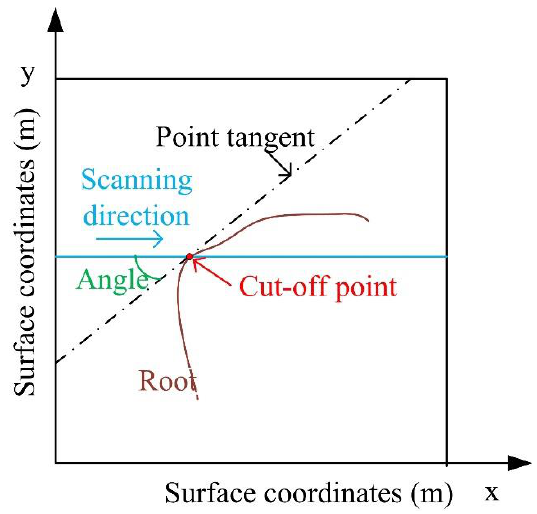
Figure 5. Definition of the included angle.